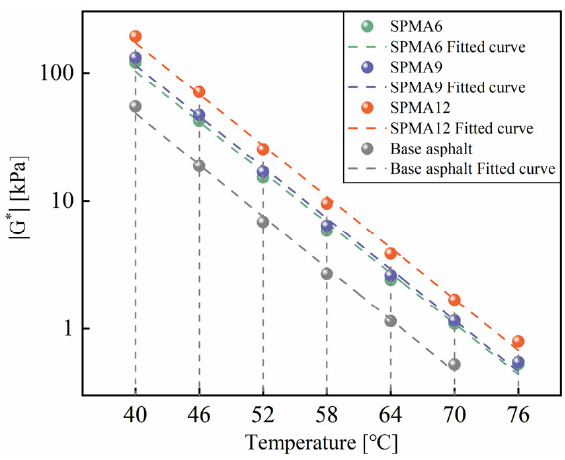
Figure 10. The phase angle of asphalt binders.